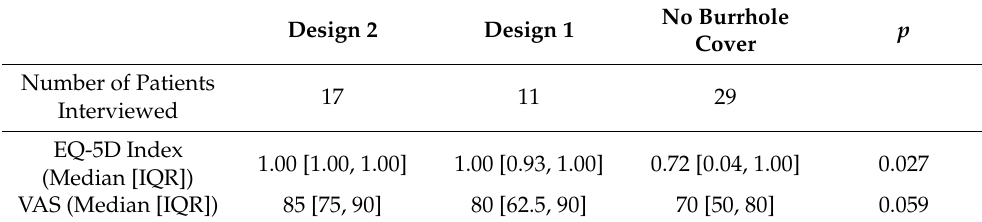
Table 5. Quality-of-life outcome